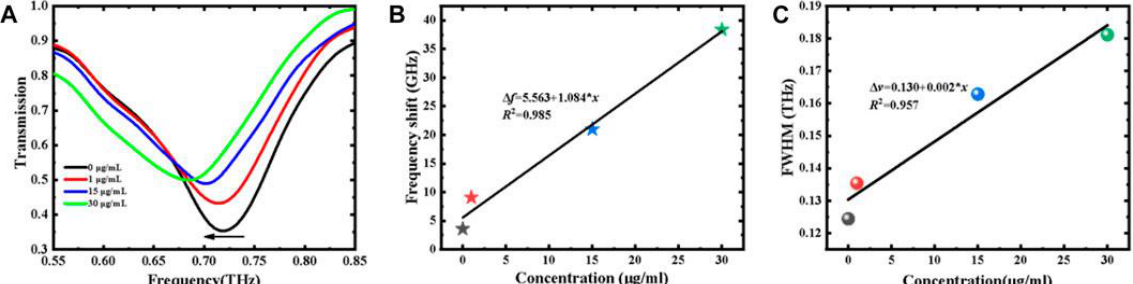
Figure 11. ( a ) Measured transmittances of the S1 protein at different concentrations. ( b ) Resonance Figure 11. ( A ) Measured transmittances of the S1 protein at different concentrations. ( B ) Resonance frequency shifts and ( c ) FWHM variation vs. concentration. Reprinted from [126]. frequency shifts and ( C ) FWHM variation vs. concentration. Reprinted from